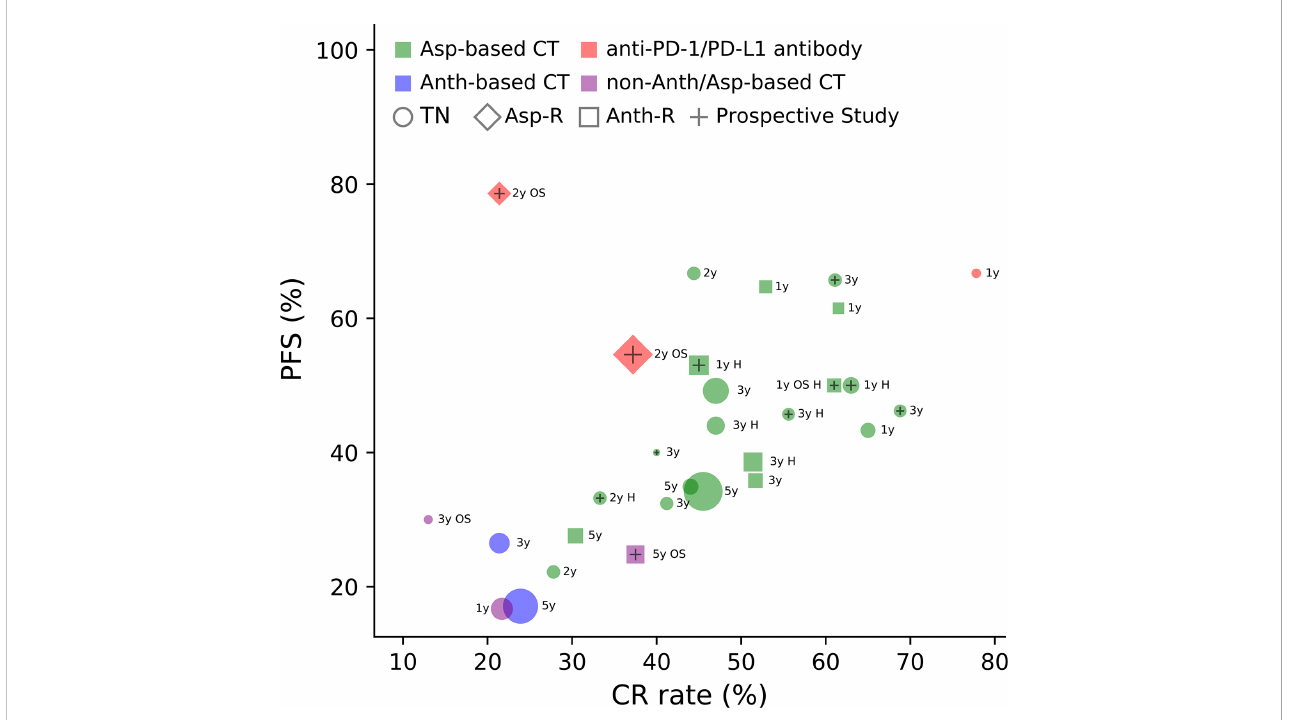
FIGURE 3 Complete response (CR) rate and progression-free survival (PFS) of patients with Ann Arbor stage III/IV or relapsed/refractory ENKTCL treated with different drug types. Asp, asparaginase; Asp-R, asparaginase-resistant; Anth, anthracycline; Anth-R, anthracycline-resistant; CT, chemotherapy; TN, treatment naïve; OS, overall survival (when PFS is not available, OS is displayed); y, year; H, hematopoietic stem cell transplantation. The area of each marker in the fi gure indicates the sample size of the study. Data are cited from (35, 68, 69, 72, 73, 82, 84, 94, 98 –